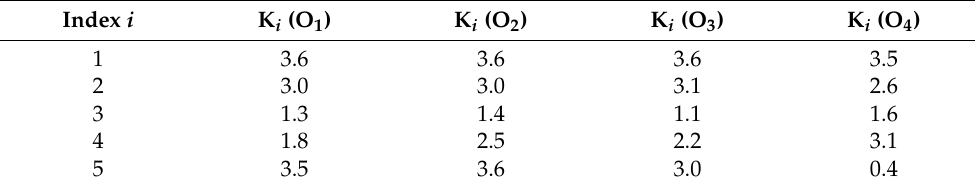
Table 3. Fitting parameters K i for each error term and polarimeter output.